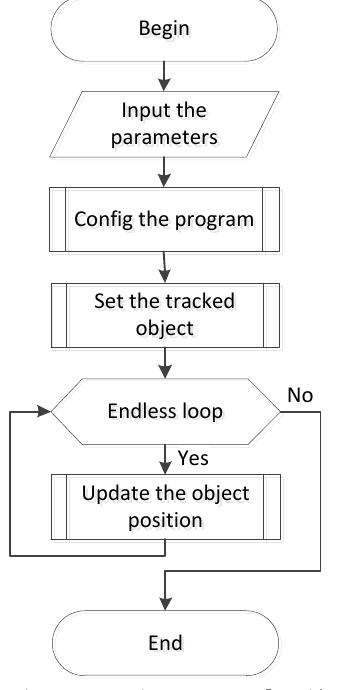
Figure 1. Main program algorithm